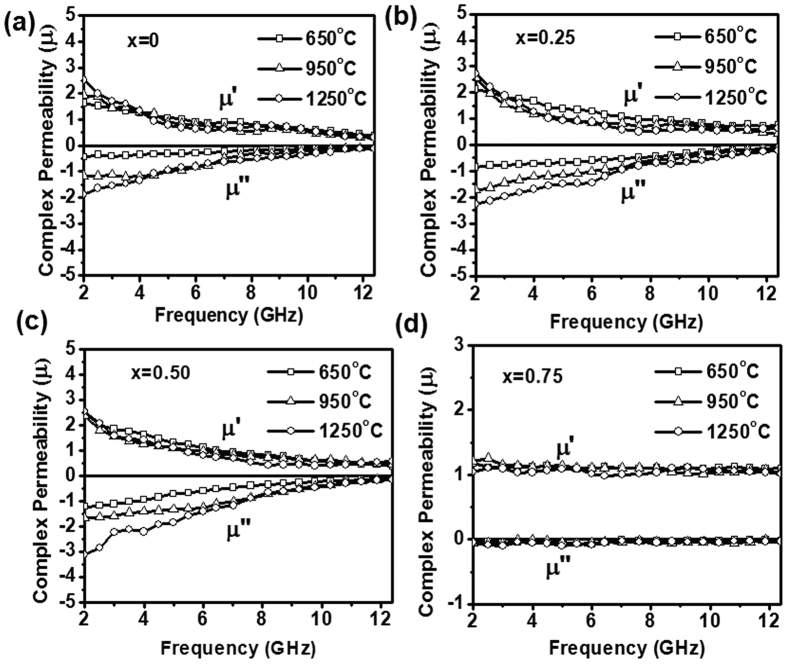
Frequency dependence of the complex permeability for annealed Ni1−xZnxFe2O4 powder (a) x = 0 (b) x = 0.25 (c) x = 0.50 (d) x = 0.75.